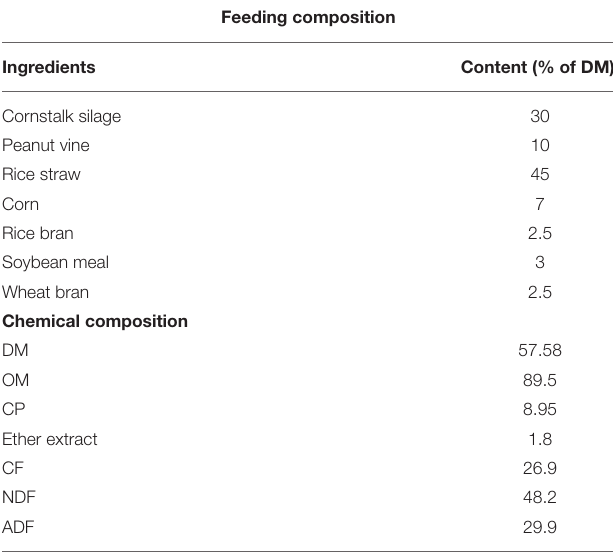
TABLE 3 | Feed composition and chemical analysis of fistulated buffalo %. Feeding